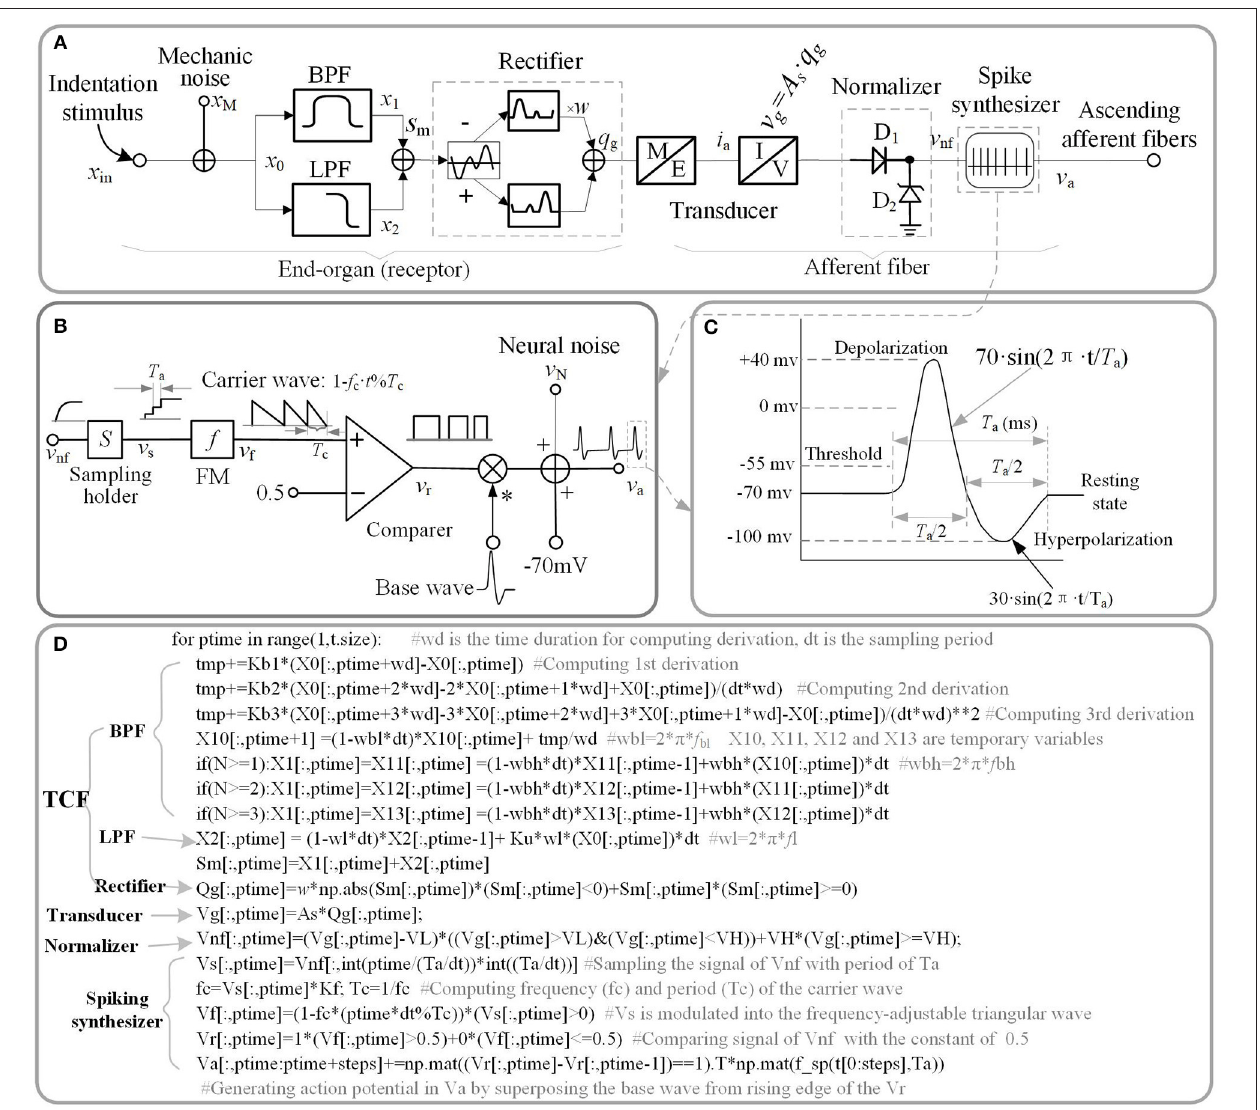
FIGURE 1 | Schematic diagram of current model. (A) Overall model of single tactile unit. x stand for the indentation displacement produced in the skin. (B) Schematic diagram of spike synthesizer. (C) Typical shape of a spike. (D) Source code of implementing schematic diagram. The ‘f_sp()’ is the function of the waveform shown in (C)